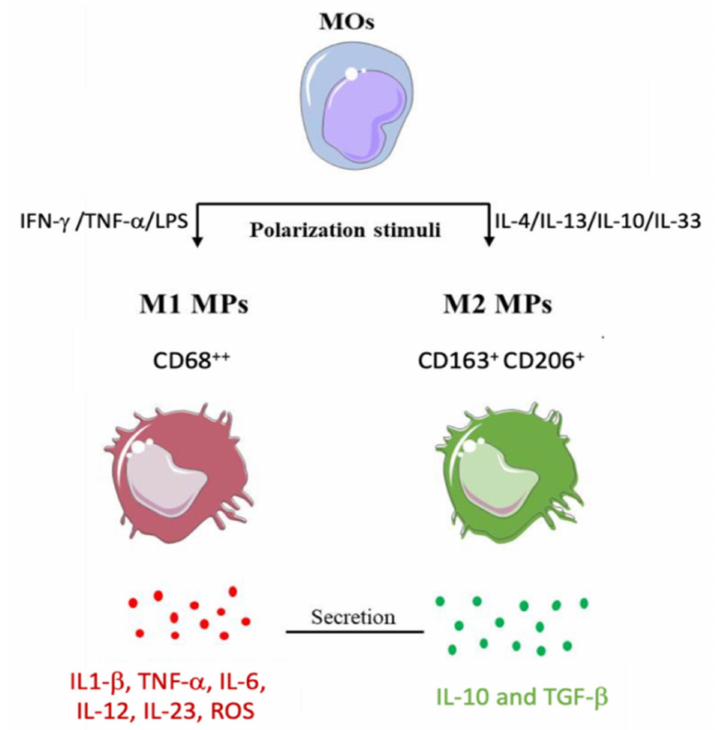
Figure 3. Schematic representation of macrophages polarization protocols adopted in vitro. Mono- cytes (MOs) evolve towards the pro-inflammatory (M1) macrophages (MPs) after T-helper 1 (Th1) response cytokines or microbial stimuli, such as lipopolysaccharide (LPS); conversely, they evolve towards anti-inflammatory (M2) macrophages (MPs) after T-helper 2 (Th2) cytokines. M1-MPs are characterized by a high expression of CD68 surface markers, the secretion of pro-inflammatory cytokines and reactive oxygen species (ROS). M2-MPs are characterized by elevated levels of CD163 and CD206 and low levels of CD68; they also secrete anti-inflammatory cytokines. Abbreviations: IFN- γ , Interferon- γ , TNF- α , Tumor Necrosis Factor- α , IL, Interleukin, TGF- β , Transforming growth factor- β